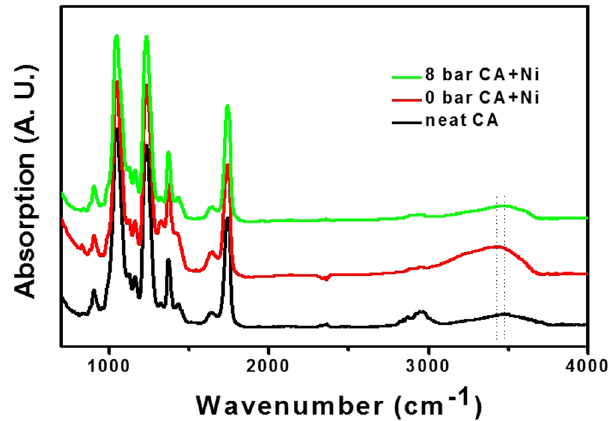
5 bar ( b ). The red dashed squares in ( b ) indicate the magnified areas shown in panes, respectively ( c ). Cross- sectional views of the samples subjected to water pressures of 5 bar ( d ).